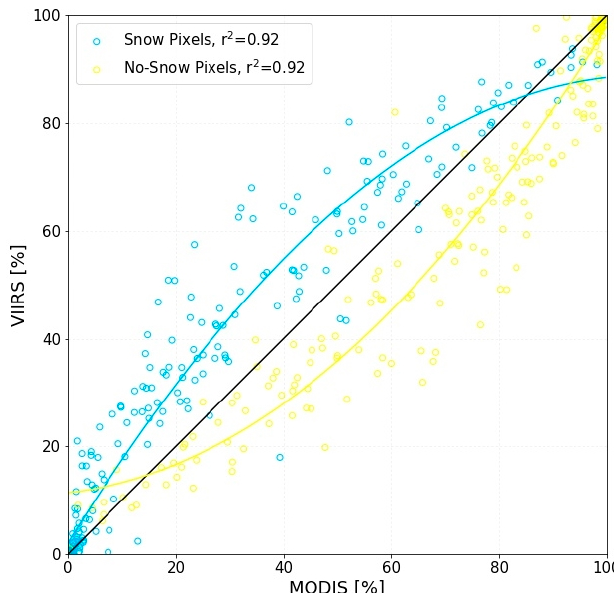
Figure 4. Scatter plots illustrating VIIRS snow and no-snow pixels with respect to MODIS snow and no-snow pixels, excluding all cloud pixels. The deep sky blue and yellow lines represent a second-degree polynomial fit for snow and no-snow pixels, respectively.